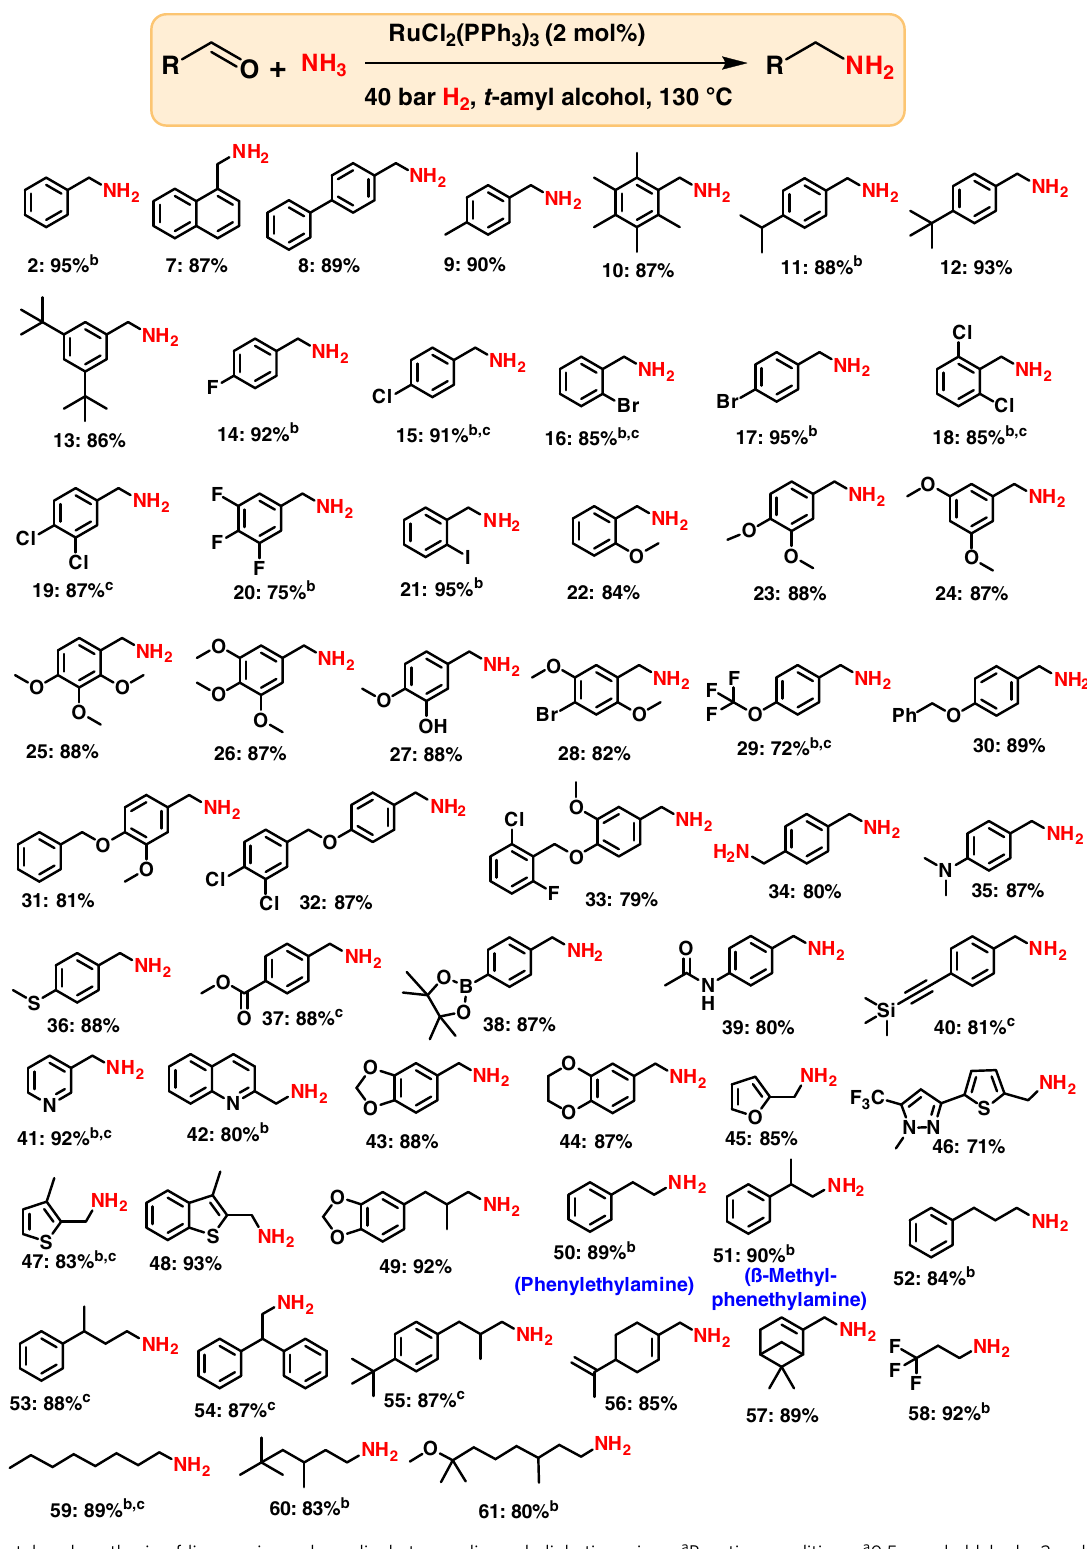
Fig. 2 Ru-catalyzed synthesis of linear primary benzylic, heterocyclic, and aliphatic amines. a Reaction conditions: a 0.5 mmol aldehyde, 2 mol% RuCl 2 (PPh 3 ) 3 , 5 – 7 bar NH 3 , 40 bar H 2 1.5 mL t -amyl alcohol, 130 o C, 24 h, isolated yields. b GC yields using n-hexadecane as standard. c same as ‘ a ’ for 30